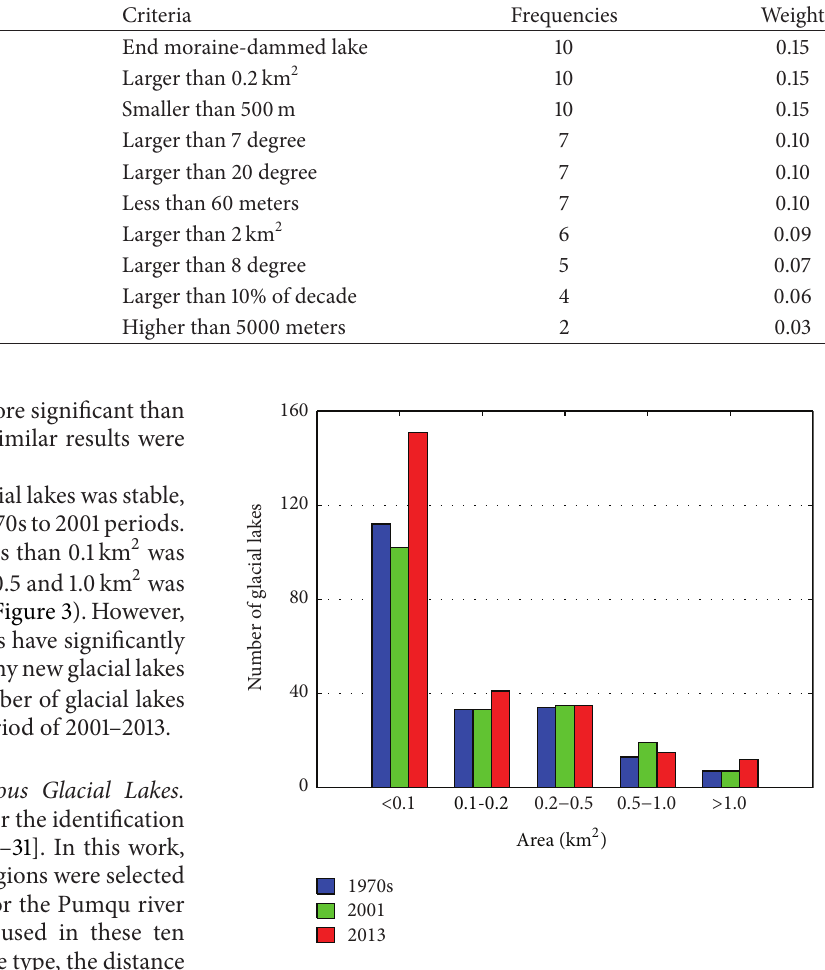
Figure 3: Changes in number and areas of glacial lakes for the 1970s, 2001, and 2013